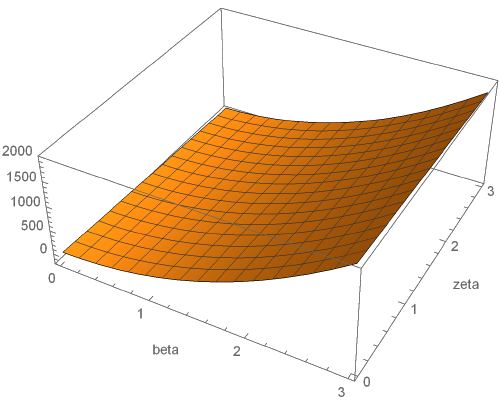
Figure 1. Plot of beta against